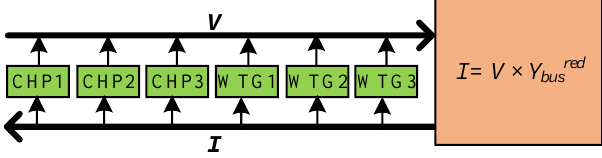
− based model of the considered bus